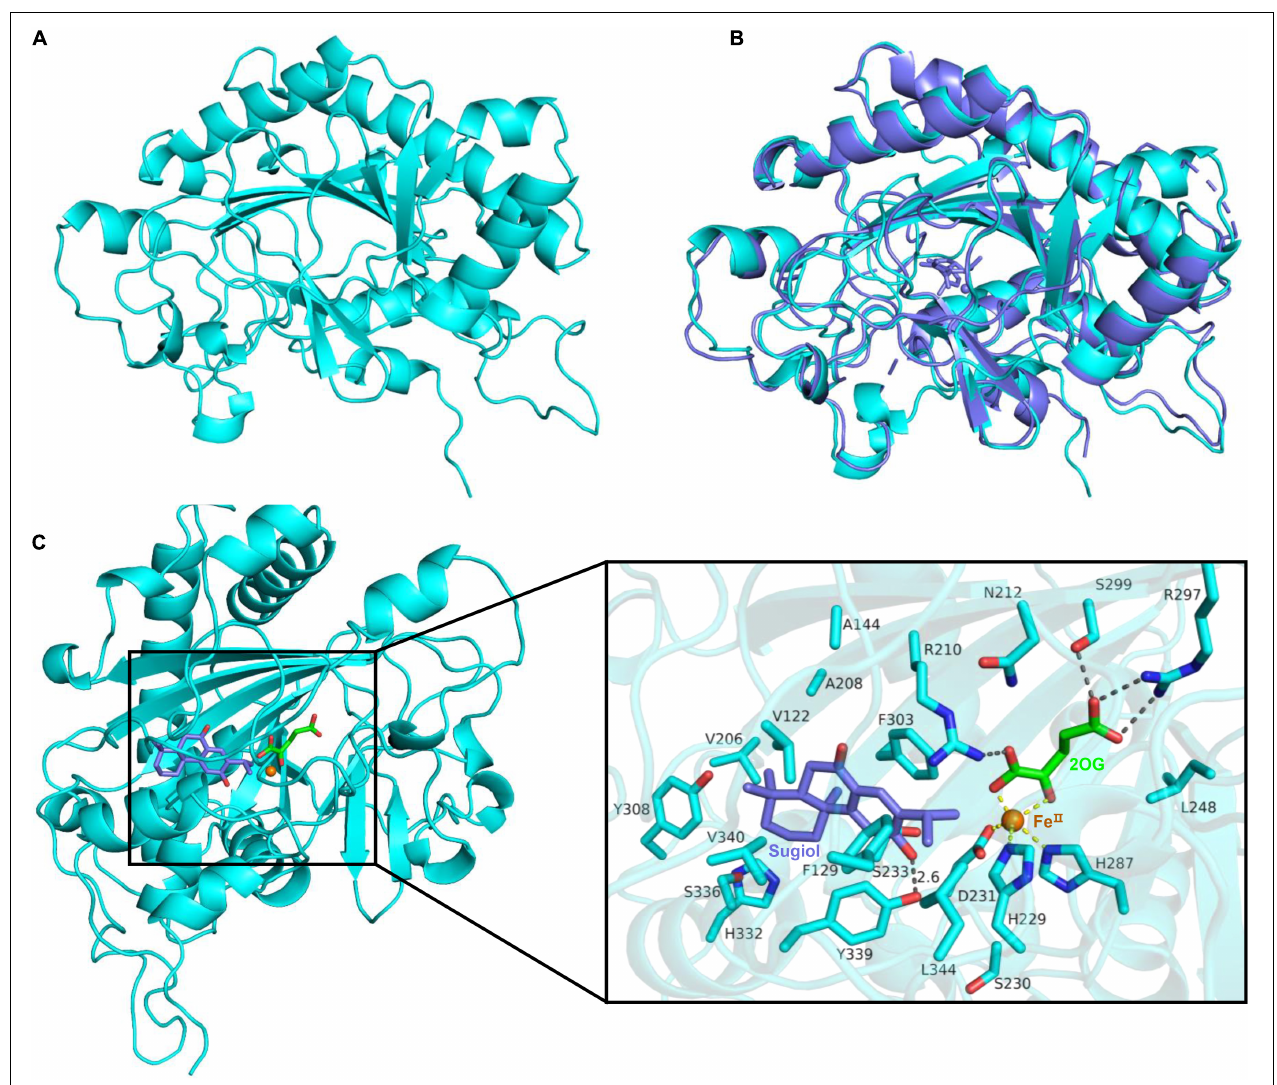
FIGURE 5 | Predicted structure, structural comparison, and substrate-binding site of Sm2OGD25. (A) 3D structure of Sm2OGD25 predicted by AlphaFold2. (B) Structural alignment of Sm2OGD25 (colored in cyan) and AtJOX2 (PDB ID: 6LSV, colored in slate). The root mean square deviation (RMSD) value is 0.99 Å for 271 C α atoms. (C) Structure modeling of Sm2OGD25. Sugiol (1) was docked into the potential binding pocket of Sm2OGD25. Residues that were close ( < 5 Å) to sugiol (1) are displayed. All protein elements are shown as cartoons or sticks in cyan. Ligands and iron are shown in different colors. The key hydrogen bond interactions are labeled in black dashed lines. The coordination with iron is labeled in yellow dashed